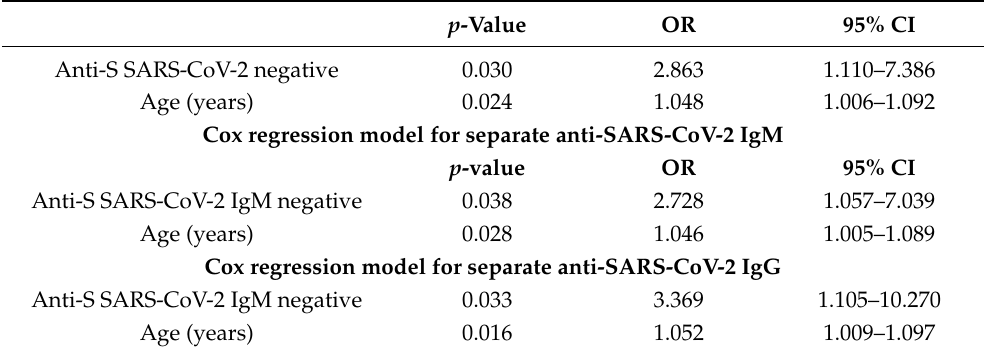
Table 4. Cox regression analysis of the association between death (during follow-up in patients discharged alive) and anti-S SARS-CoV-2 negativity and other variables.